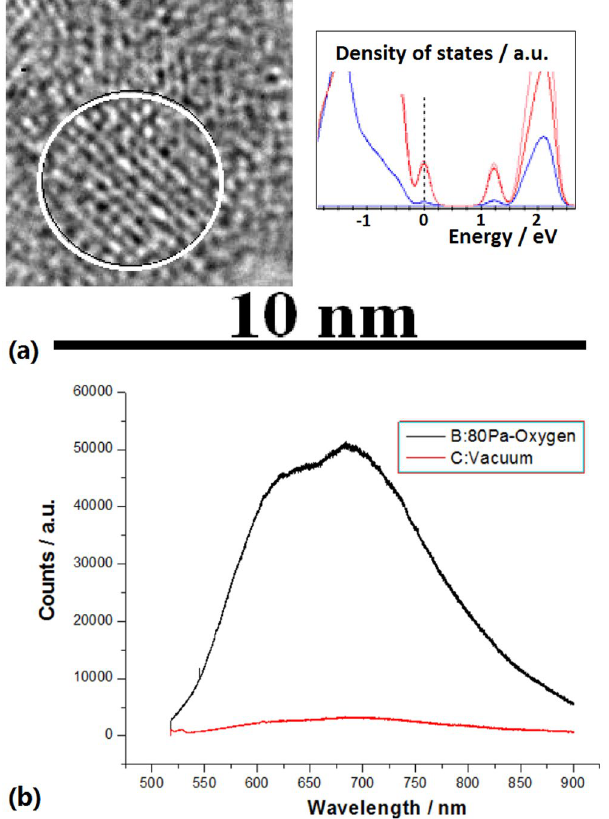
Figure 5. ( a ) The TEM image showing the bigger Si QDs doped with oxygen of 80 Pa, and the inset showing the density distribution of states with the localized states originated from impurities on nanocrystals in the simulating calculation; ( b ) The comparison for the PL spectra from 550 nm to 850 nm measured in the visible layer, in which the red curve is related to the spectrum on the sample I prepared in vacuum and the black curve is related to the spectrum on the sample II prepared in oxygen owing to the localized electronic states from the bigger nanocrystals doped with